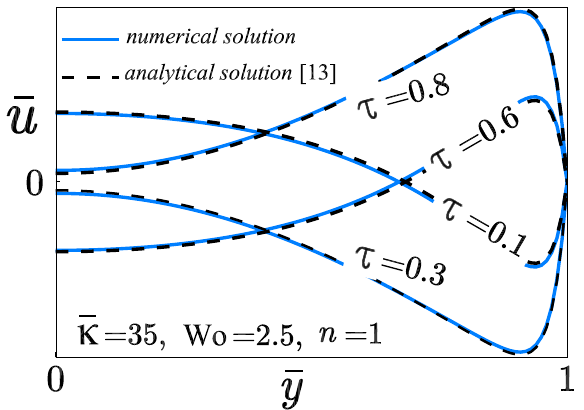
Figure 3. Comparison of the analytical solution [13] and the numerical solution (present work) for the dimensionless velocity ¯ u across the microchannel in a Newtonian